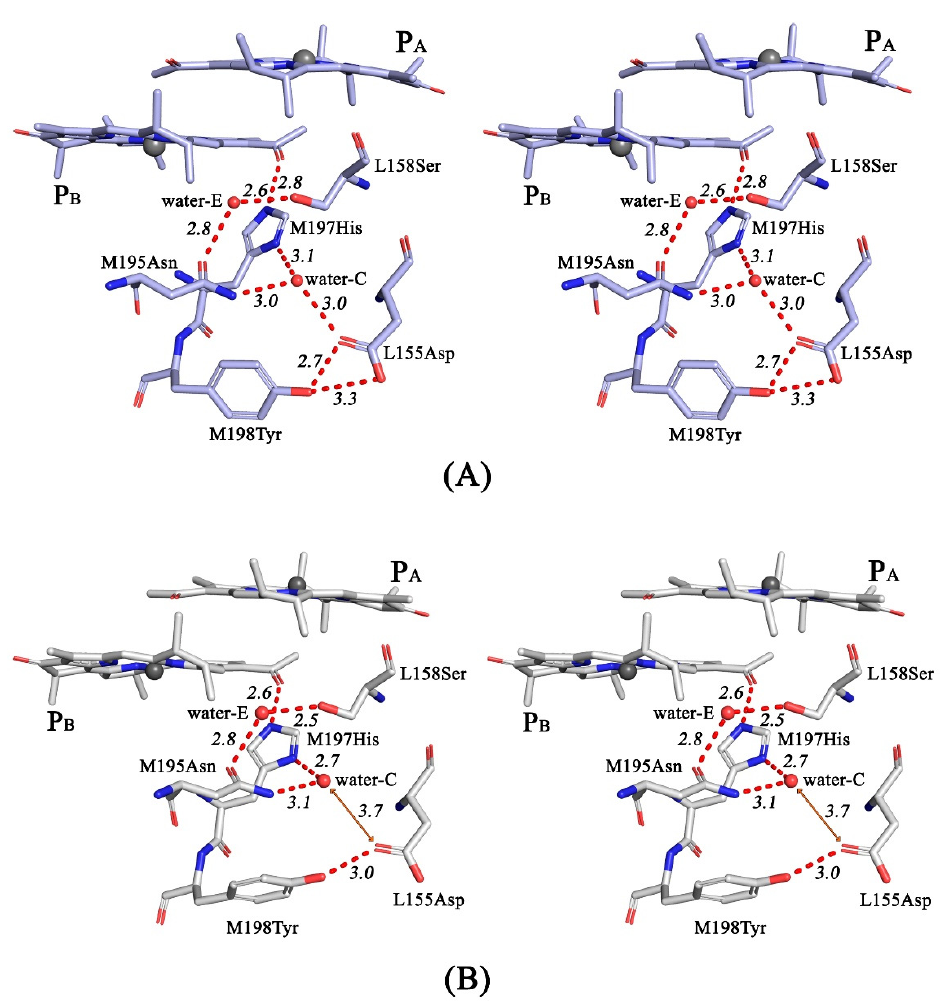
Figure 6. Stereoviews of the hydrogen-bonding networks in the proximity of the M197 residue in F(M197)H ( A ) and RC I(L177)H + F(M197)H ( B ). All distances are shown in RC F(M197)H ( A ) and RC I(L177)H + F(M197)H ( B ). All distances are shown in Å.